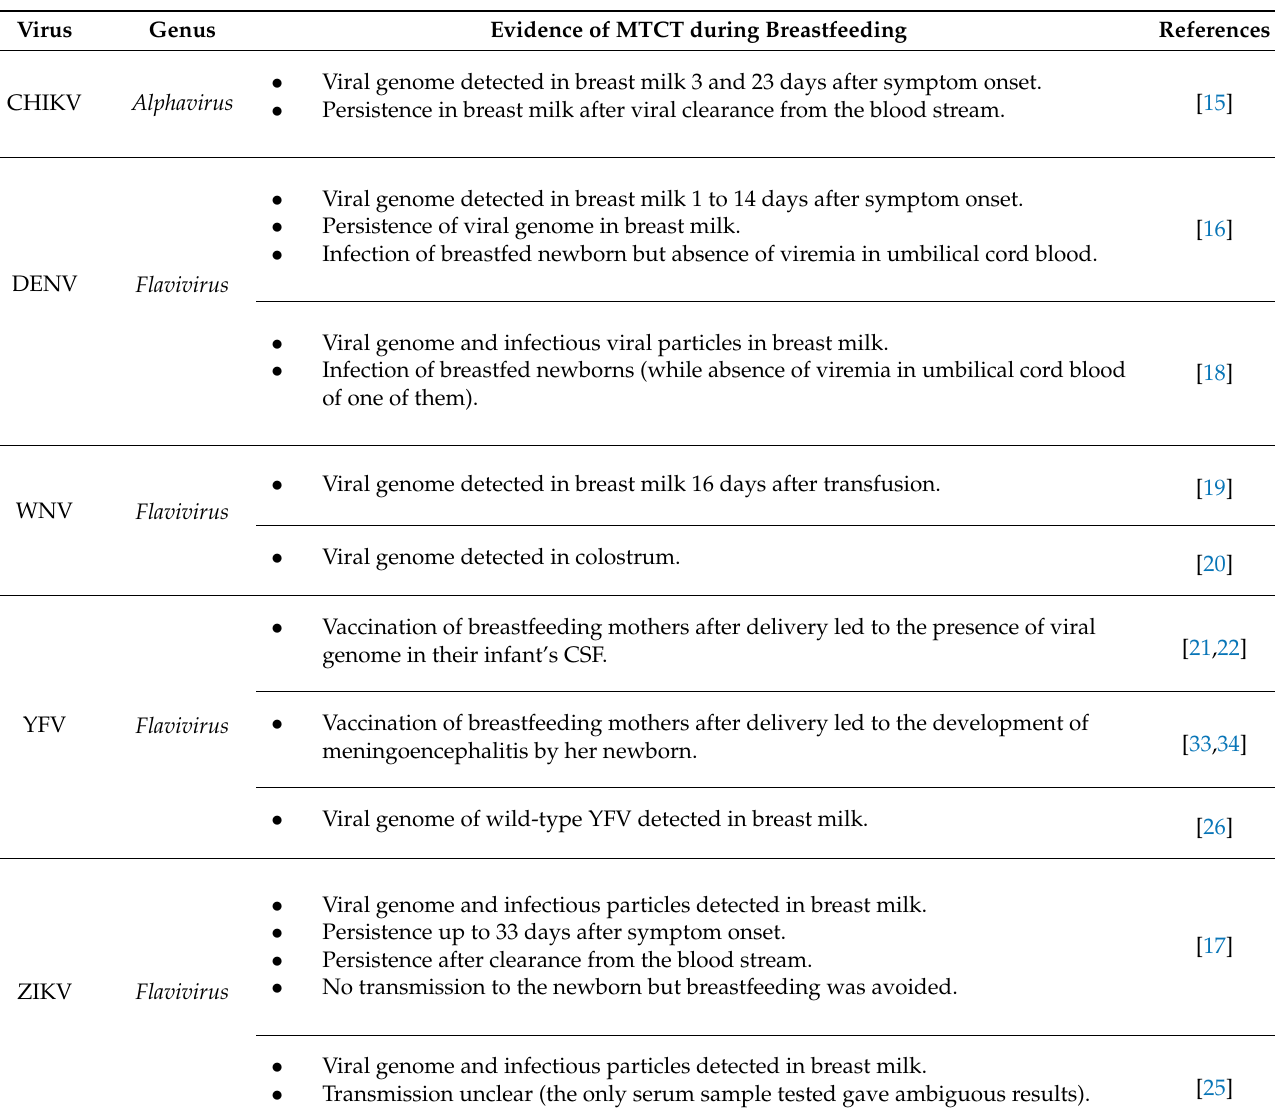
Table 1. Epidemiological and clinical evidence of milk-borne